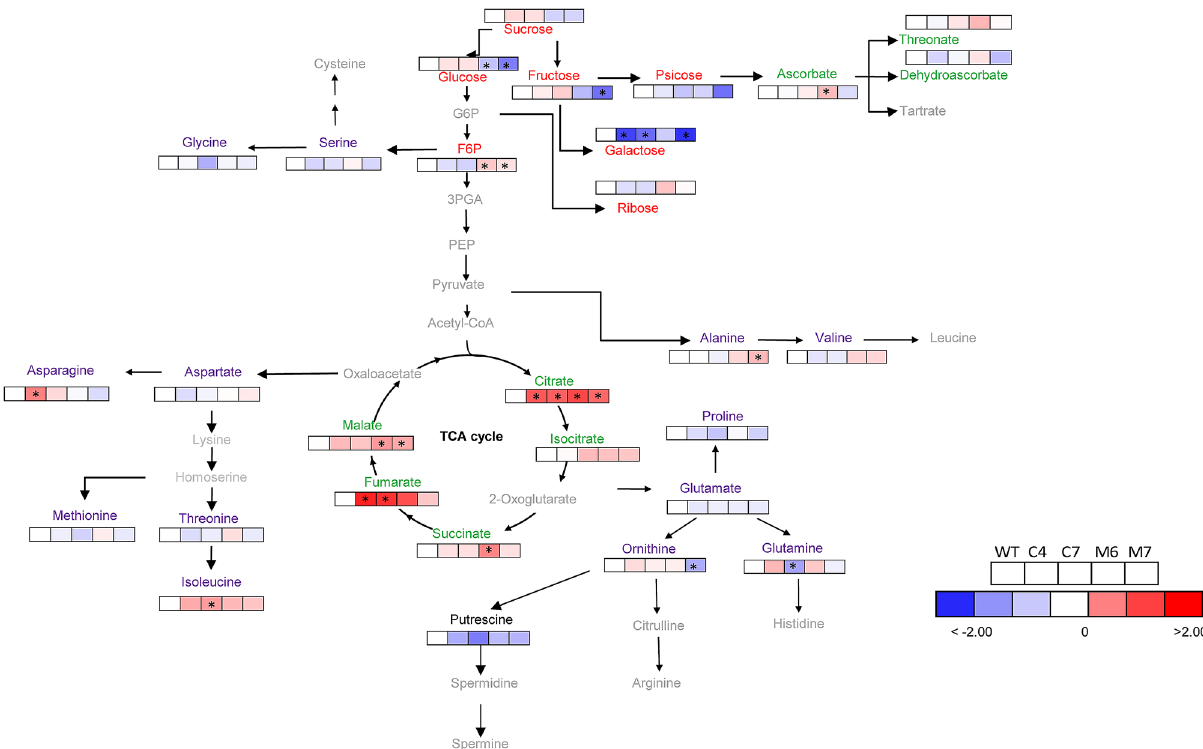
Figure 7. Representative metabolites pathway changes in HXK3 transgenic lines of Arabidopsis thaliana plant growing under optimal condition. Amino acids, organic acids, sugars, and sugar alcohols were determined by GC/MS as described in M&M section. The full data sets from these metabolic profiling studies are additionally available in Supplementary Table S2. Data is normalized with its respective wild-type (Columbia-0) (to allow statistical assessment, individual plants from this set were normalized in the same way). The color code of the heat map is given at the log2 following the scale above the diagram. Different colors represent levels of metabolite fold change where red is increasing and blue is decreasing. Values are presented as means ± SE (n = 5). Asterisks indicate that the values from transgenic lines were determined by Student’s t test to be significantly different ( P < 0.05) from the wild